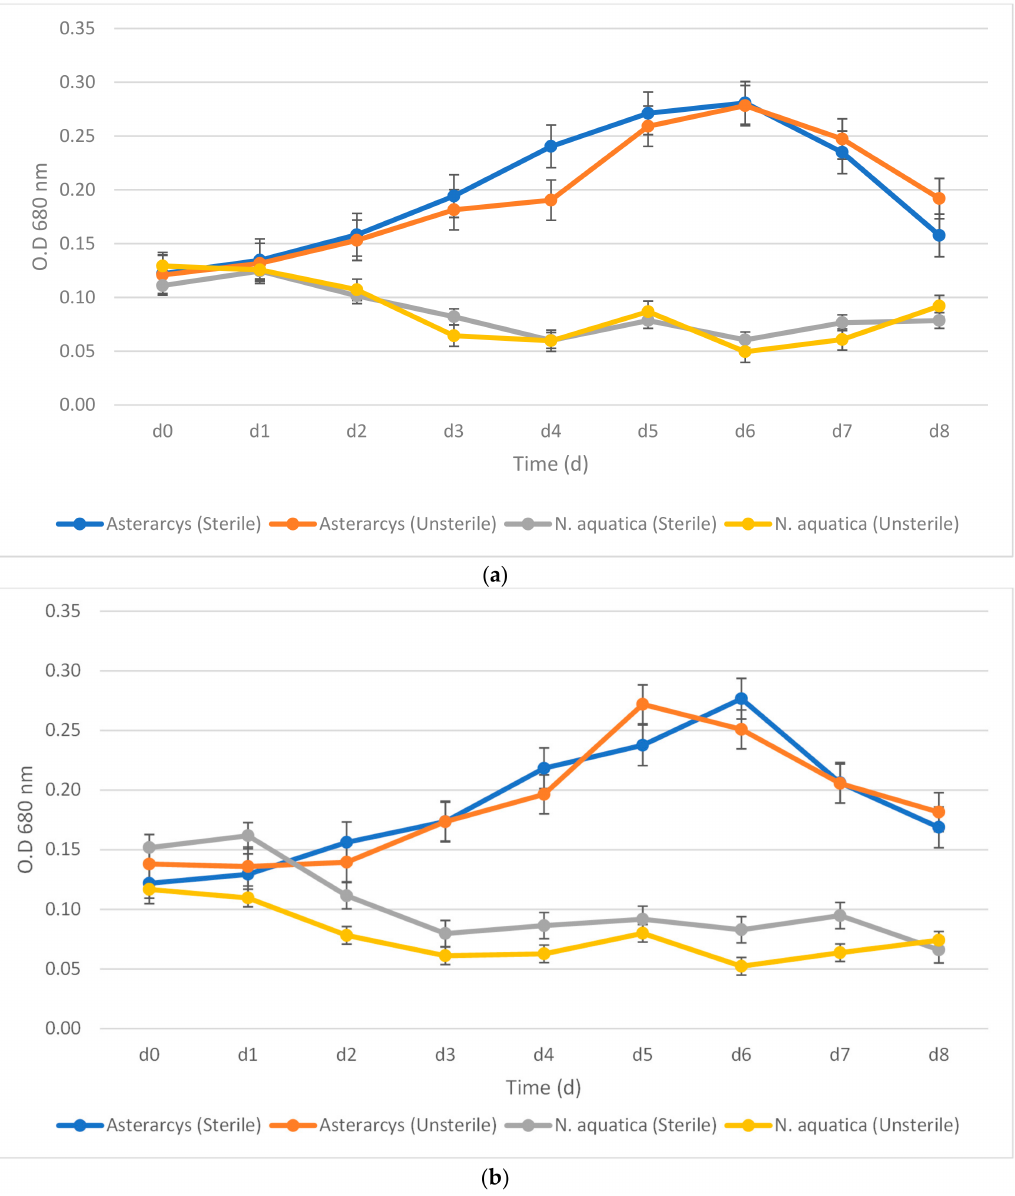
Figure 1. Growth rate of microalgae cultivated in treated wastewater effluent from the Northern wastewater treatment works (NWWTW) ( a ) and Umbilo wastewater treatment plant (UWWTP) ( b